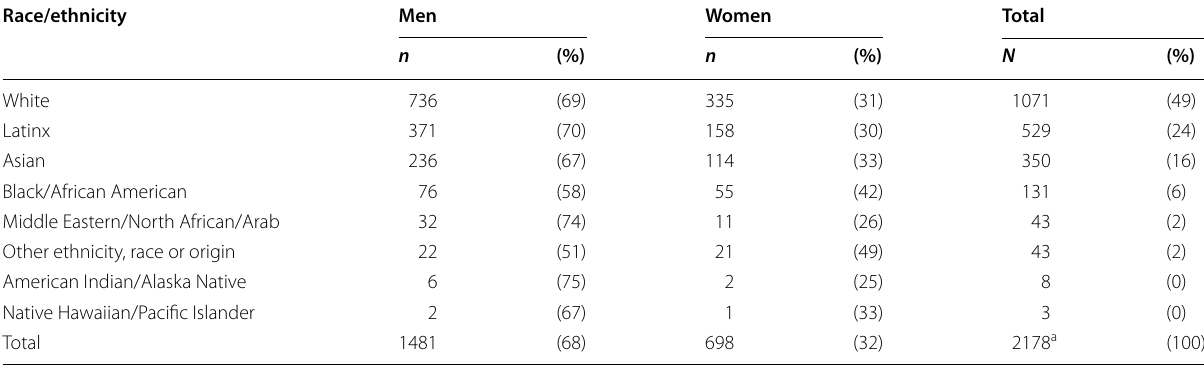
a 8 respondents did not indicate race/ethnicity, thus the total sample size was 2186